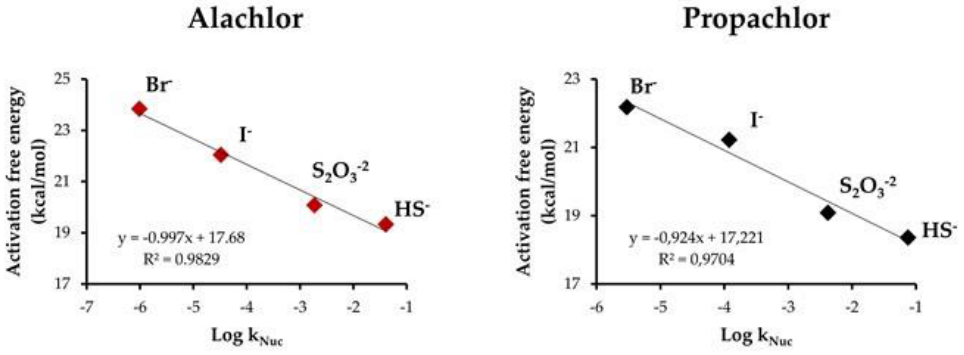
Figure 2. Log knuc vs. activation free energy for alachlor and propachlor. R 2 = coefficient of determination, y = activation free energy, x = log k nuc .